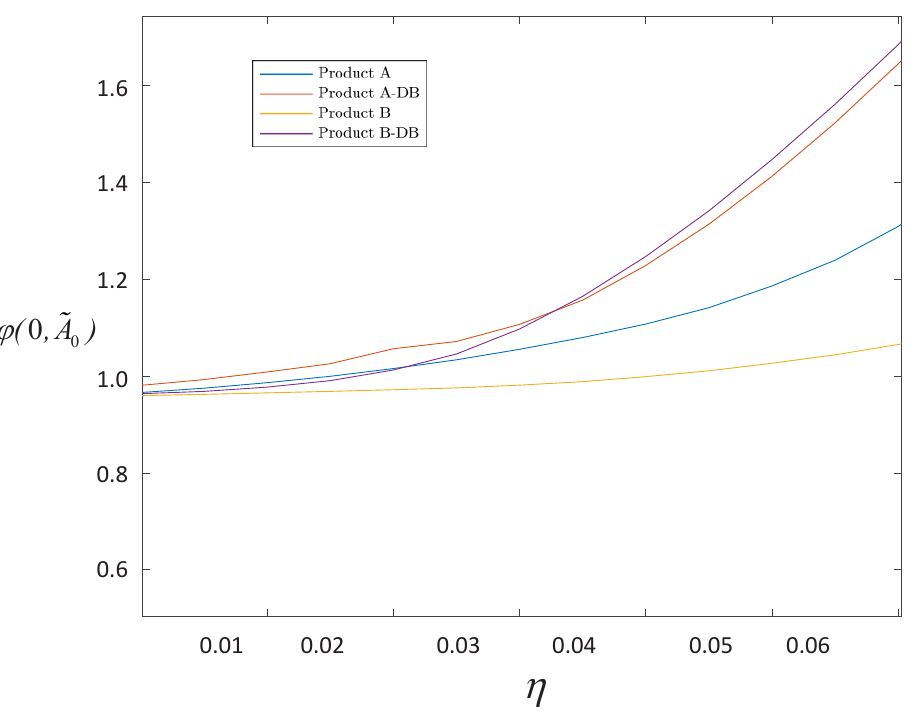
Figure A7. The contract value at inception as a function of the roll-up rate η for Product A and B with and without DB for 2% r =